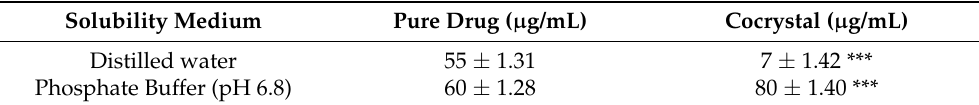
Table 1. Saturation solubility of AZT DH and cocrystal.